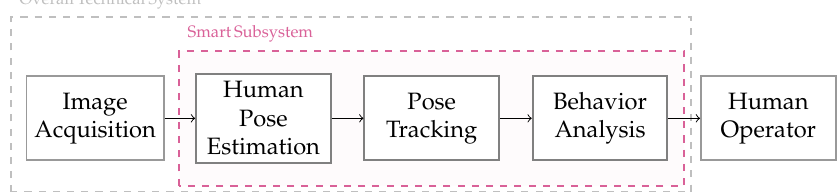
Figure 1. Simplified schematic block diagram showing a possible workflow in smart video surveil- lance as an aiding system. A video management system (VMS) is responsible for the data acquisition and provides the data to the smart subsystem. The output of the subsystem is then provided to the VMS, which presents it to the human operator. The human operator then takes these results and decides whether to perform additional steps (e.g. send a police officers to the location) or ignore them.